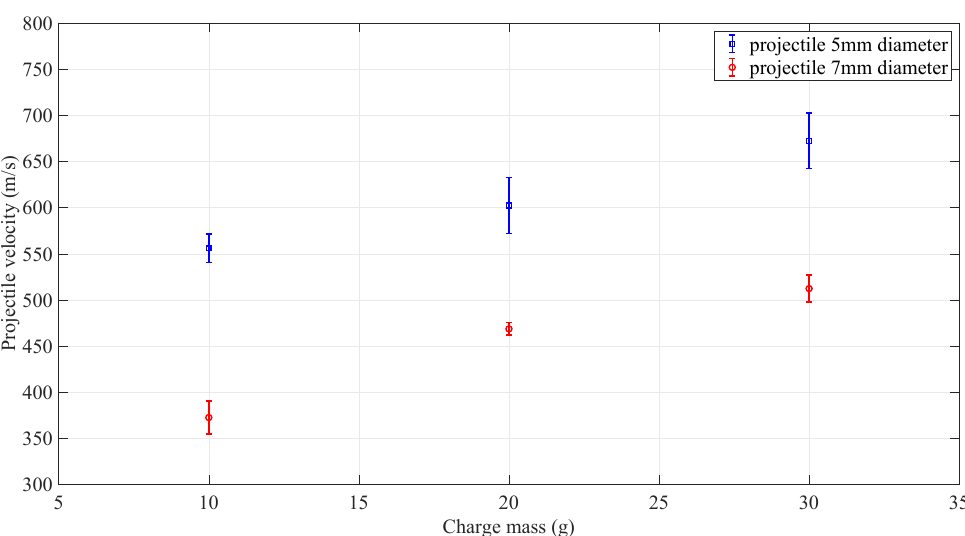
Figure 10. Mean projectile velocity with standard deviation for projectiles with diameters of 5 and 7 mm as a function of the charge mass.